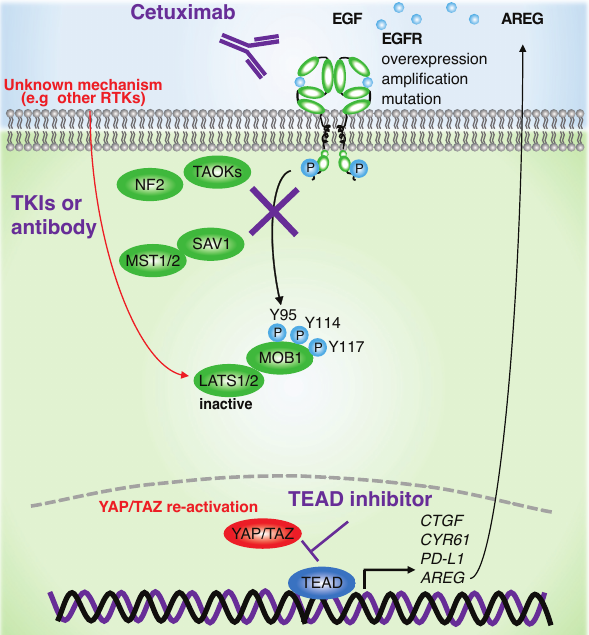
Figure 4. Schematic of the role of Hippo pathway and YAP/TAZ in cetuximab resistance. Cetuximab treatment inactivates EGFR, which in turn reduces tyrosine phosphorylation of MOB1 and activated LATS1/2, resulting in transient YAP/TAZ inactivation. However, unknown mechanisms, includ- ing reactivation or overexpression of other receptor types of tyrosine kinases (RTKs), re-activate YAP/TAZ, leading to intrinsic or acquired resistance to cetuximab treatment. Combination therapy with cetuximab and a TEAD inhibitor may be beneficial for avoiding YAP/TAZ reactivation and tumor relapse. AREG denotes amphiregulin (also abbreviated